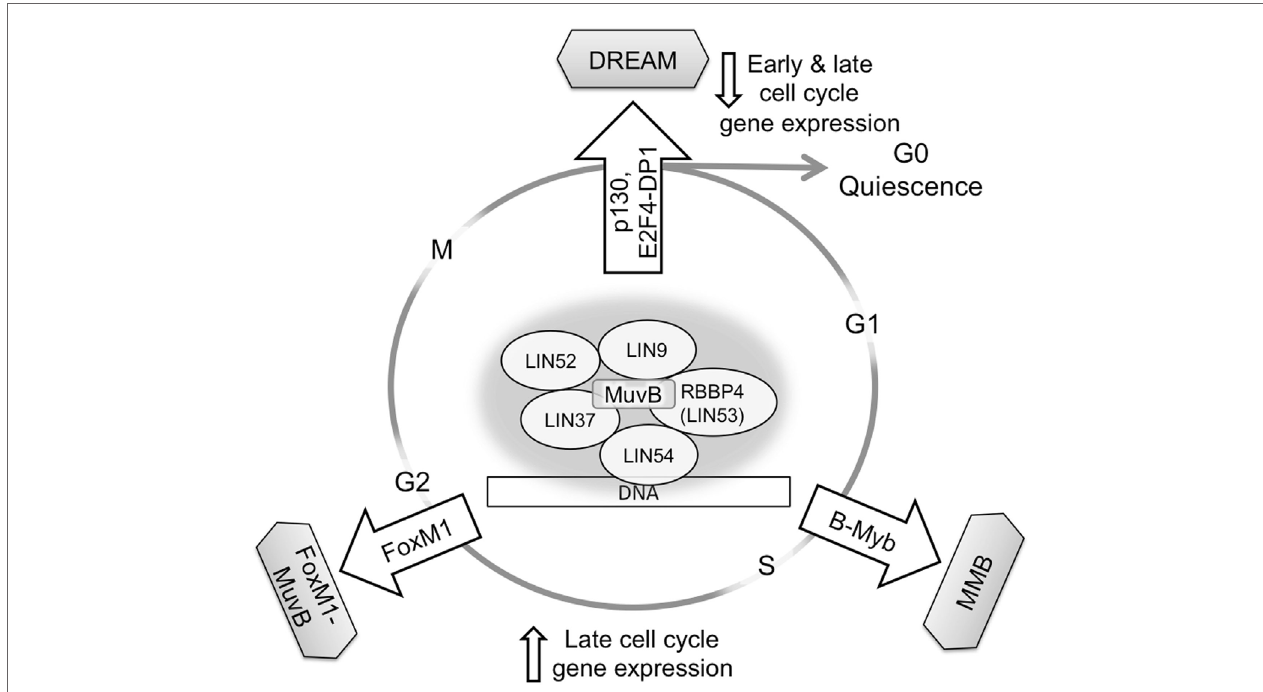
FiGURe 1 | MuvB contributes to gene regulation throughout the cell cycle. MuvB binds p130/p107 and E2F4-DP1 in G0/G1 to form the DREAM complex and repress both early and late cell cycle genes. Upon cell cycle re-entry and during the S phase, MuvB binds B-Myb, forming MMB for expression of early cell cycle genes. The interaction between B-Myb and MuvB is important for recruiting FoxM1 for late cell cycle gene expression and subsequent mitosis.